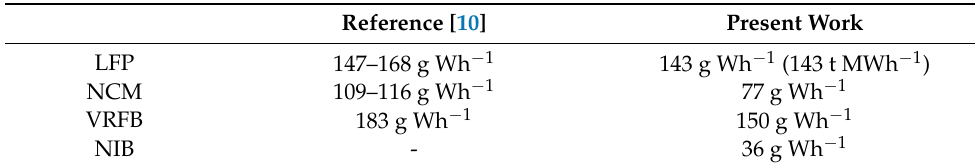
Table 6. Global warming potential (GWP) for the different batteries. The functional unit refers to the storage